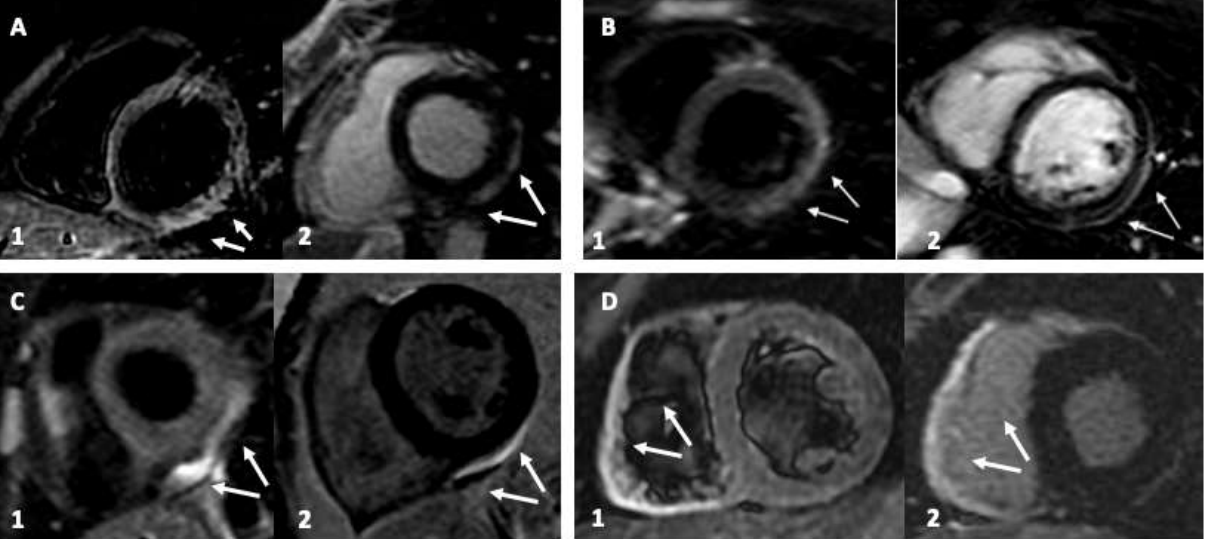
Figure 1. Cardiac magnetic resonance (CMR) imaging of young patients with vaccine-related myocar- dial involvement. Panel ( A , B ): Inferolateral myocardial involvement with edema and late gadolinium enhancement (LGE), with a subepicardial and pericardial distribution typical of myocarditis. Panel ( C ): Only pericardial involvement. Panel ( D ): isolated right ventricle involvement. Sub-Panel 1, triple IR (Triple-IR) FSE T2-weighted images for myocardial edema detection. Sub-Panel 2, LGE images.